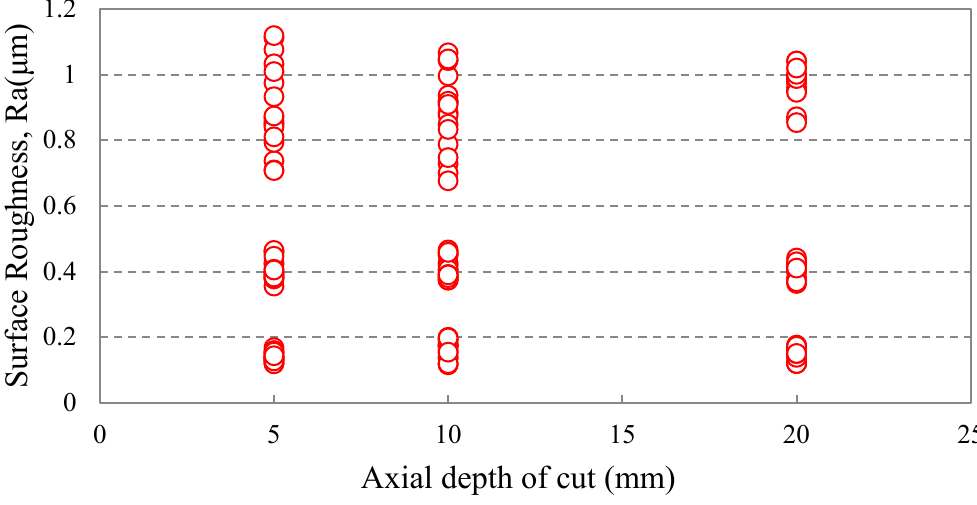
Figure 13. Roughness distribution graph in terms of axial depth of cut.